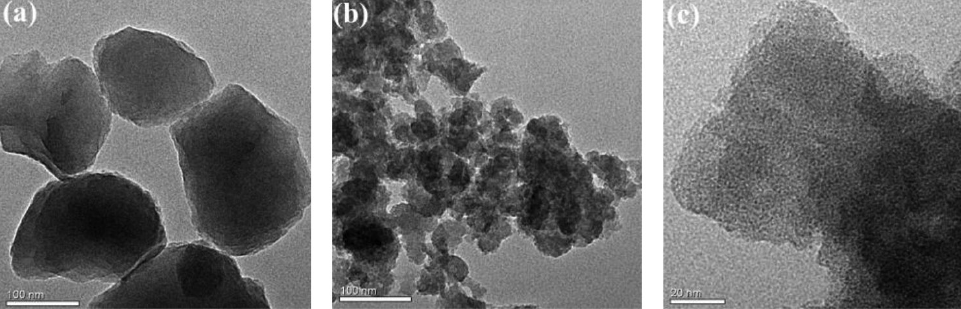
Figure 4: TEM images of UiO-66(a) and NiHSiW/UiO-66 (b,c)